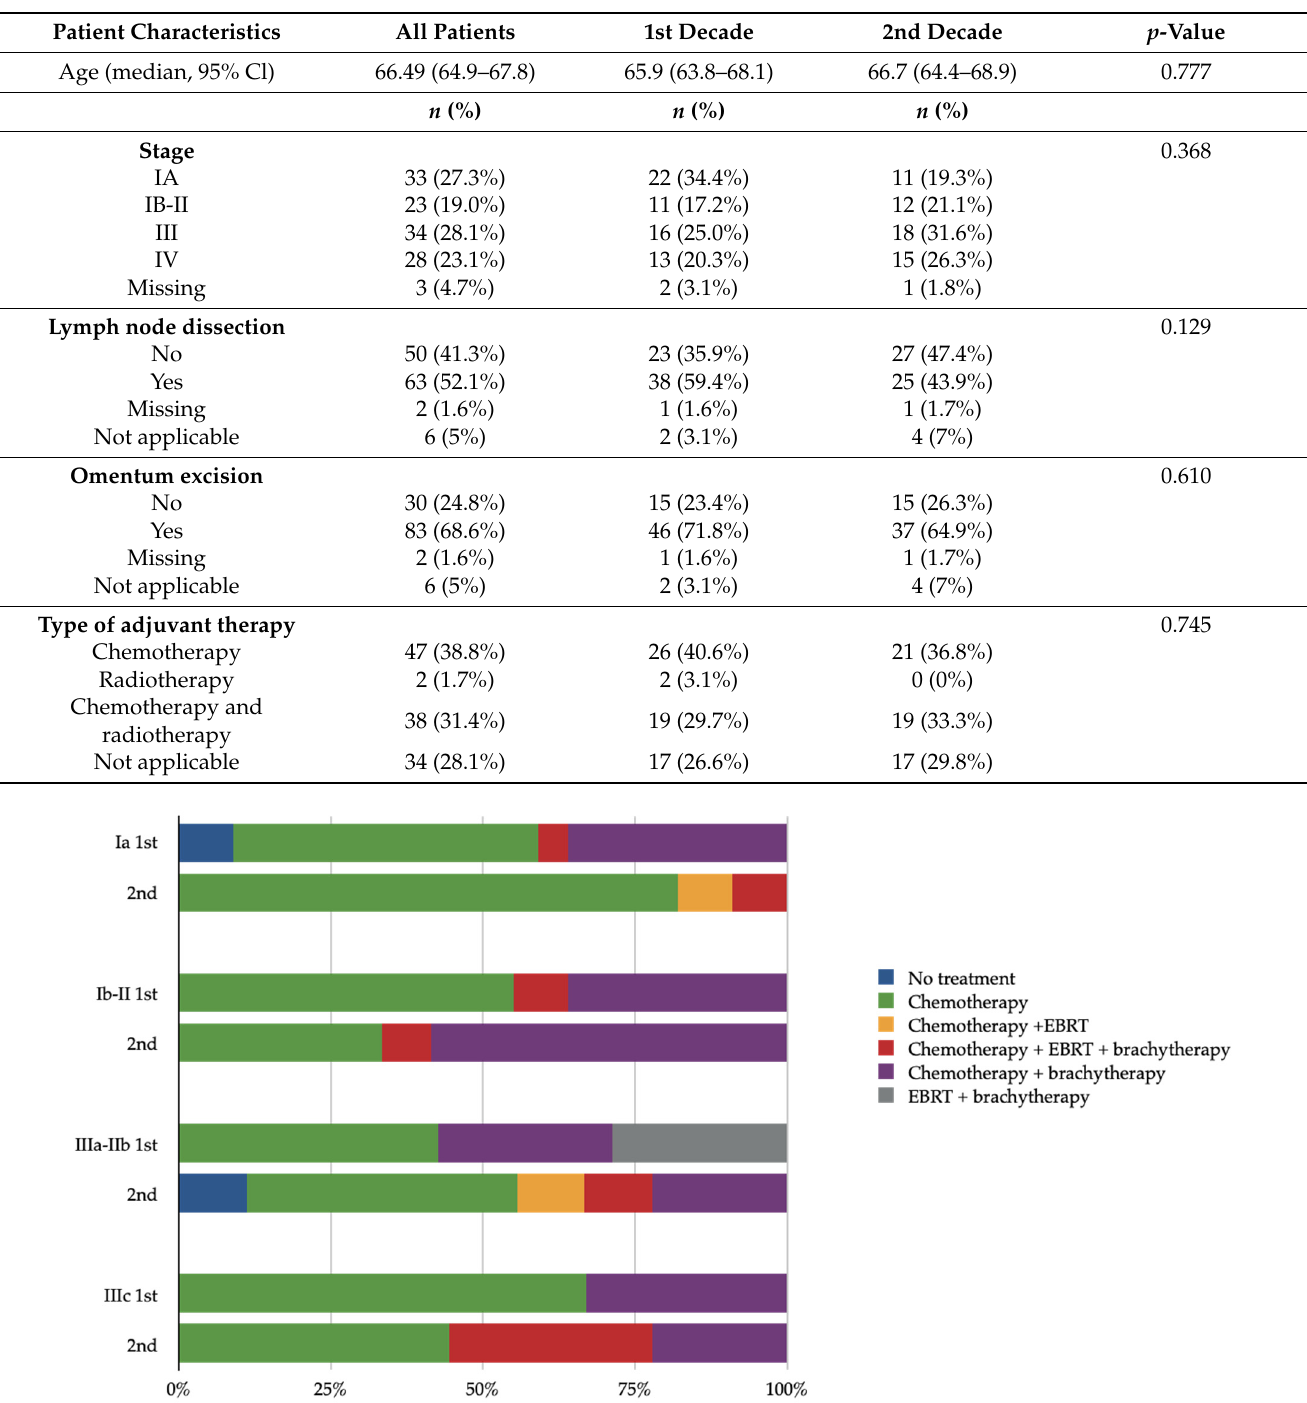
Table 1. Patients’ characteristics.